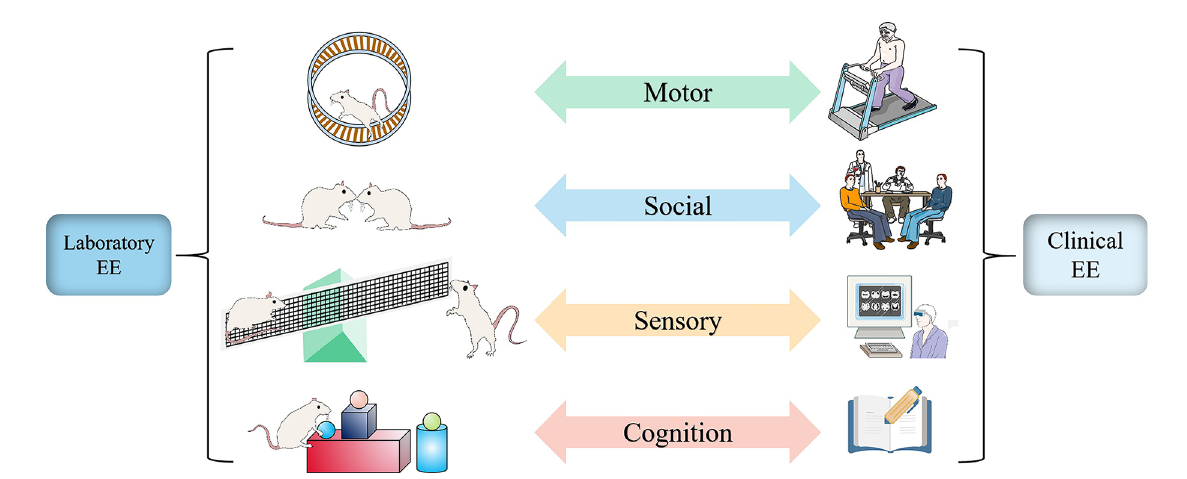
FIGURE1 Similarity and correspondence between laboratory EE setting and clinical EE intervention. Whether laboratory or clinical, EE always provides motor, sensory, social, and cognitive stimulation to achieve positive changes in function and structure. In physical activity, animals are voluntarily active on a running wheel to match the patient on a treadmill or more diverse exercise (Green); in social stimulation, EE in the laboratory allows for extensive social interaction between animals by increasing the number of animals to match patients in the ward or treatment hall to communicate with other patients or doctors about their conditions or preferred treatment options (Blue). In sensory, animals are involved in touching a series of toys, such as seesaws, swings, and pipes, to match the patient’s experience of proprioception, touch, hearing, and other stimuli through virtual reality technology (Yellow). In terms of cognition, Animals recognize the color and shape of objects to match the patient’s participation in reading, playing games, and chess according to their interests to improve learning and memory skills